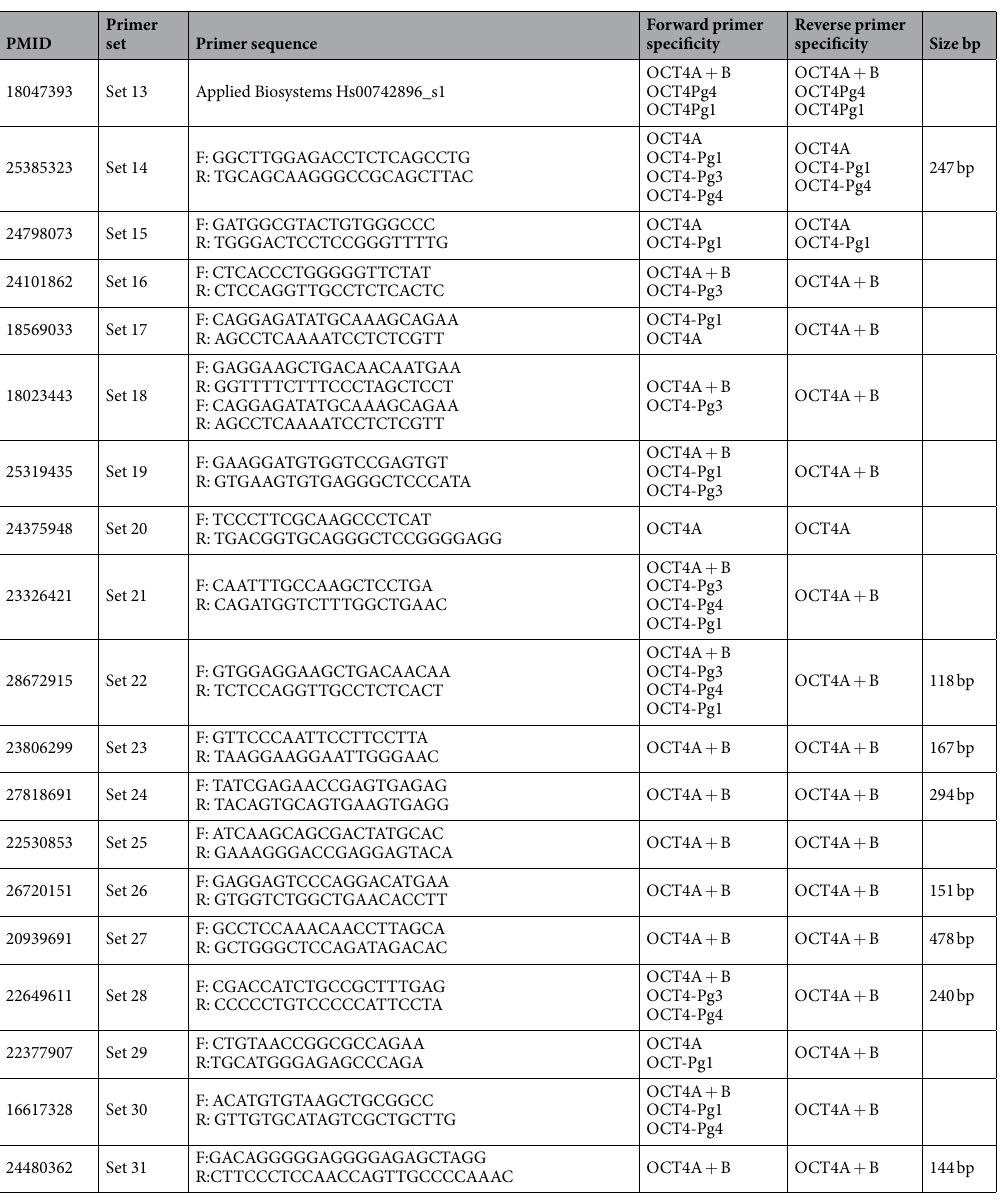
Table 2. List of primers used in the references listed in Table 1. Y: yes, N: no, C: study includes appropriate